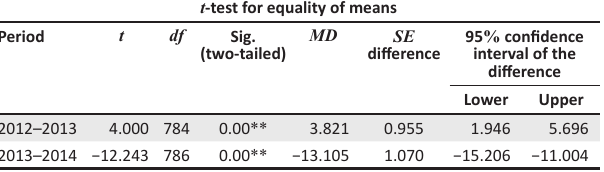
TABLE 4: t - test for mean difference for cohorts 2012 and 2013.